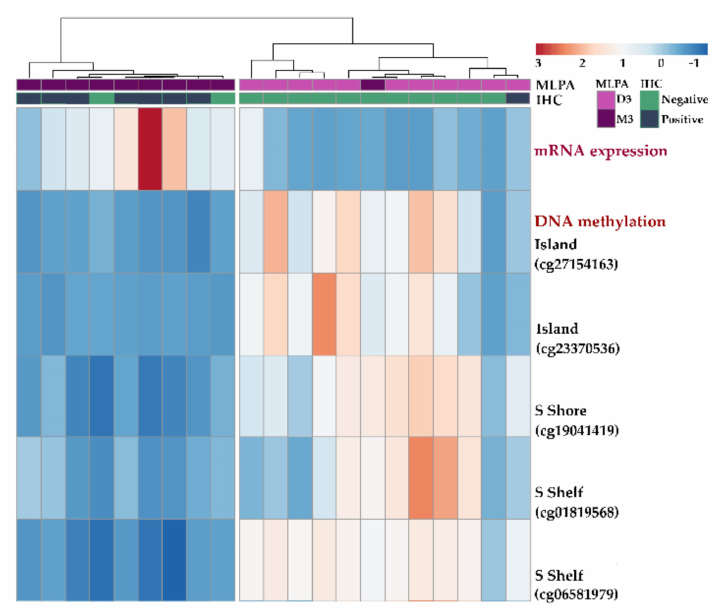
Figure 7. Heatmap showing the correlation between mRNA expression and DNA methylation. Only five representative probes located in regulatory regions of the KIT gene are shown. The red color in the histogram represents high signal intensity and methylation β value for individual positions, while the blue color represents a low signal intensity and methylation β value.